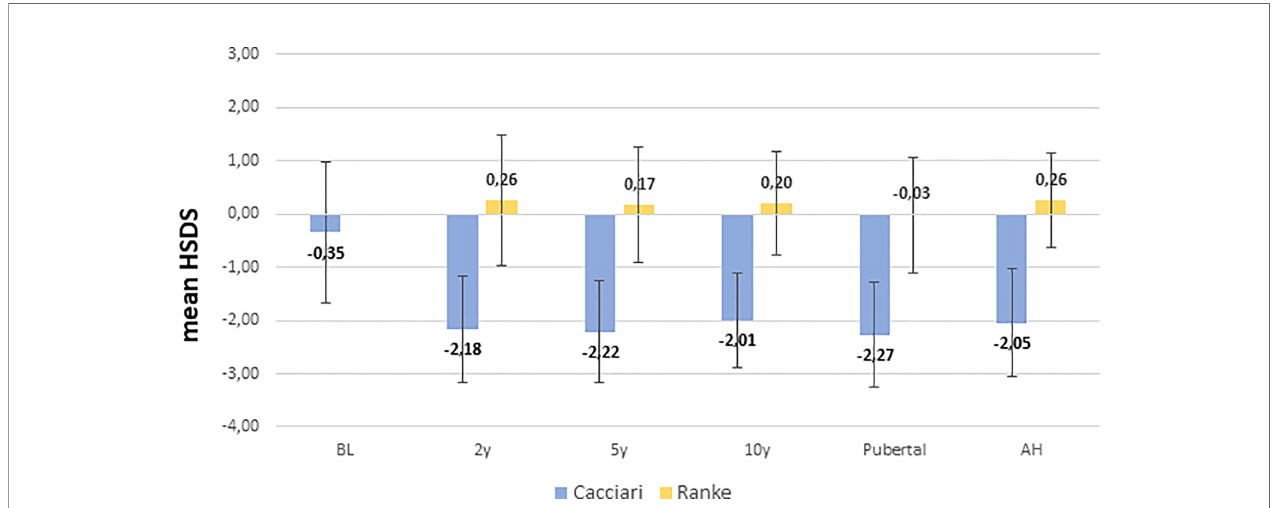
FIGURE 2 | Height SDS from birth to AH according to Cacciari and Ranke standard. BL, birth length; H: HSDS measured at 2, 5, 10 years, at pubertal onset, and at adult height (AH).